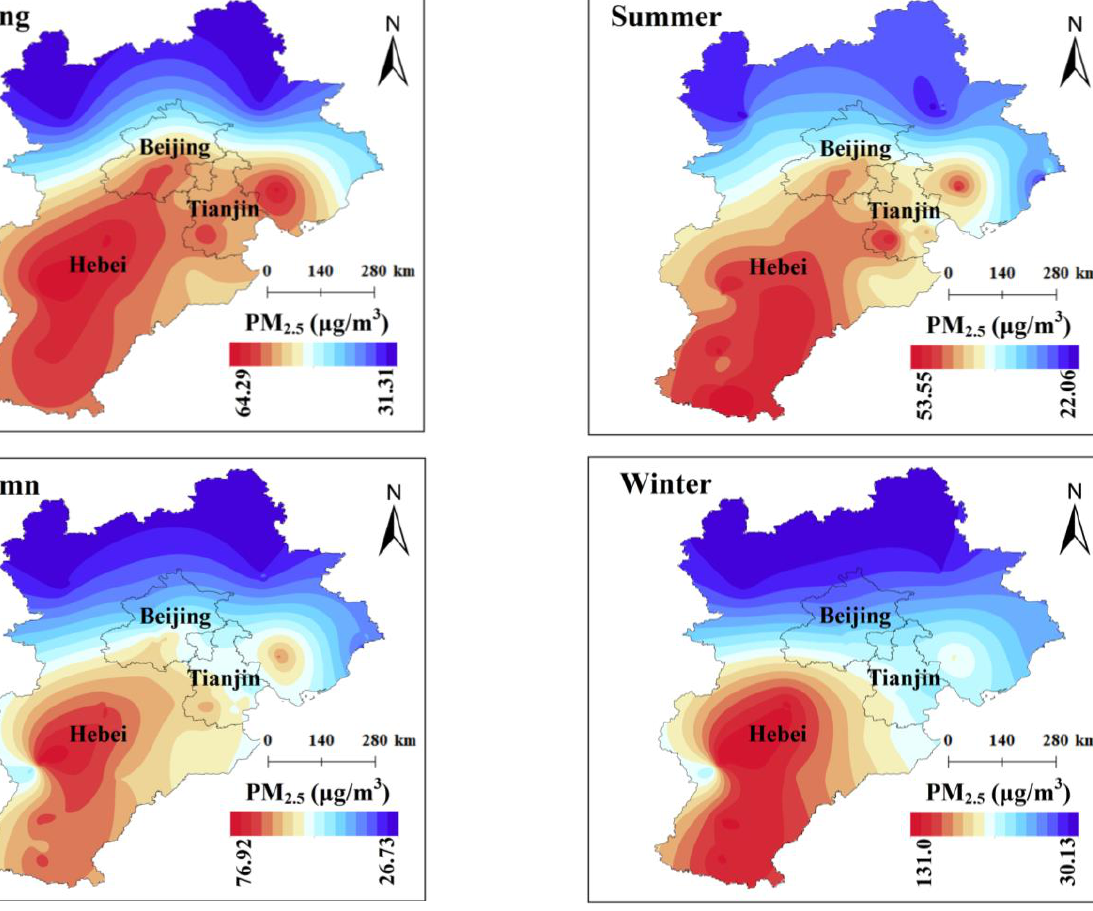
Figure 4. Seasonal variation of PM 2.5 concentrations in the BTH region.